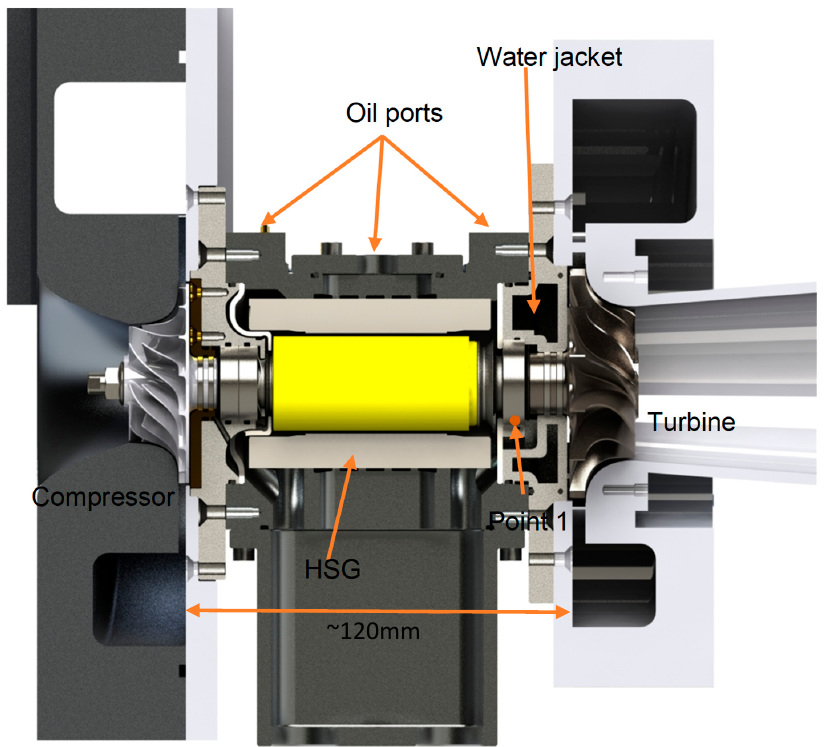
Figure 1. Cutaway of City University of London’s 6 kWe MGT showing its components and indicating the distance between the turbine and compressor.